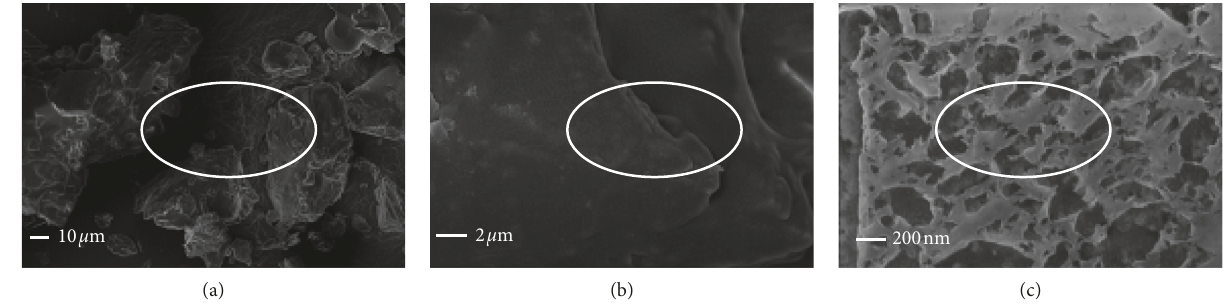
Figure 4: The images of NaNO 3 under different ratios of the SEM